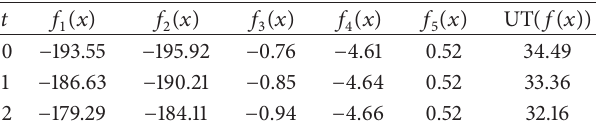
Table 7: The solutions of the subproblems according to different values of 𝑡 for Example